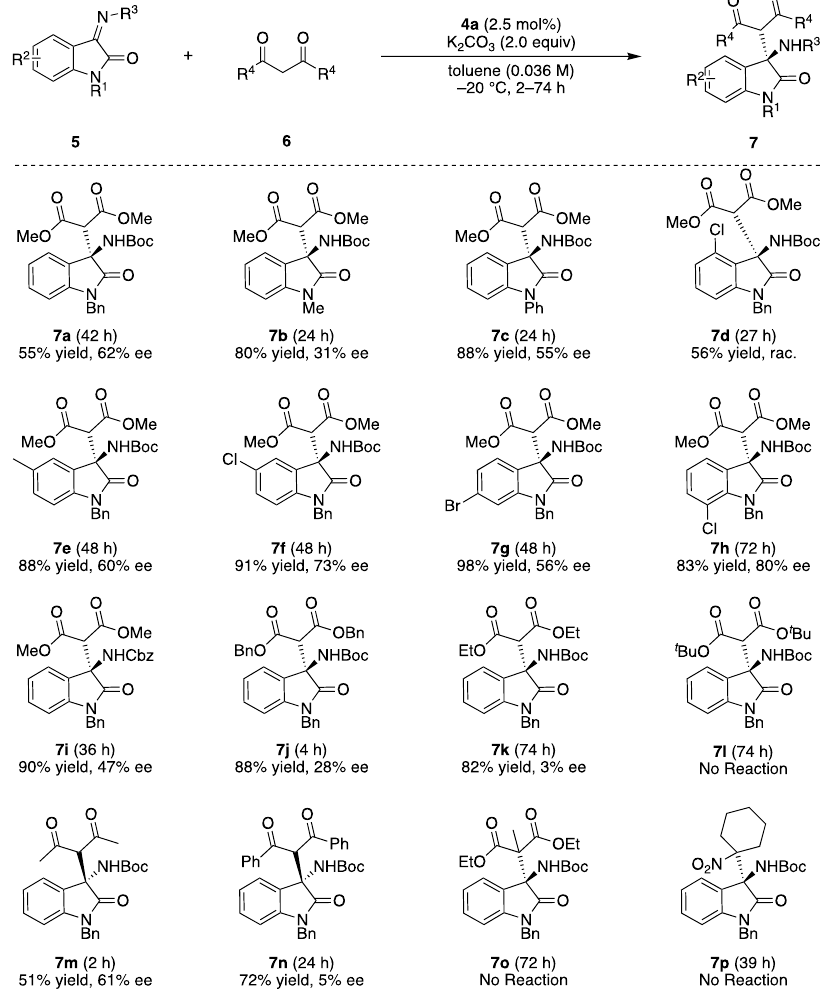
Figure 2. Substrate scopes. Isolated product yields are